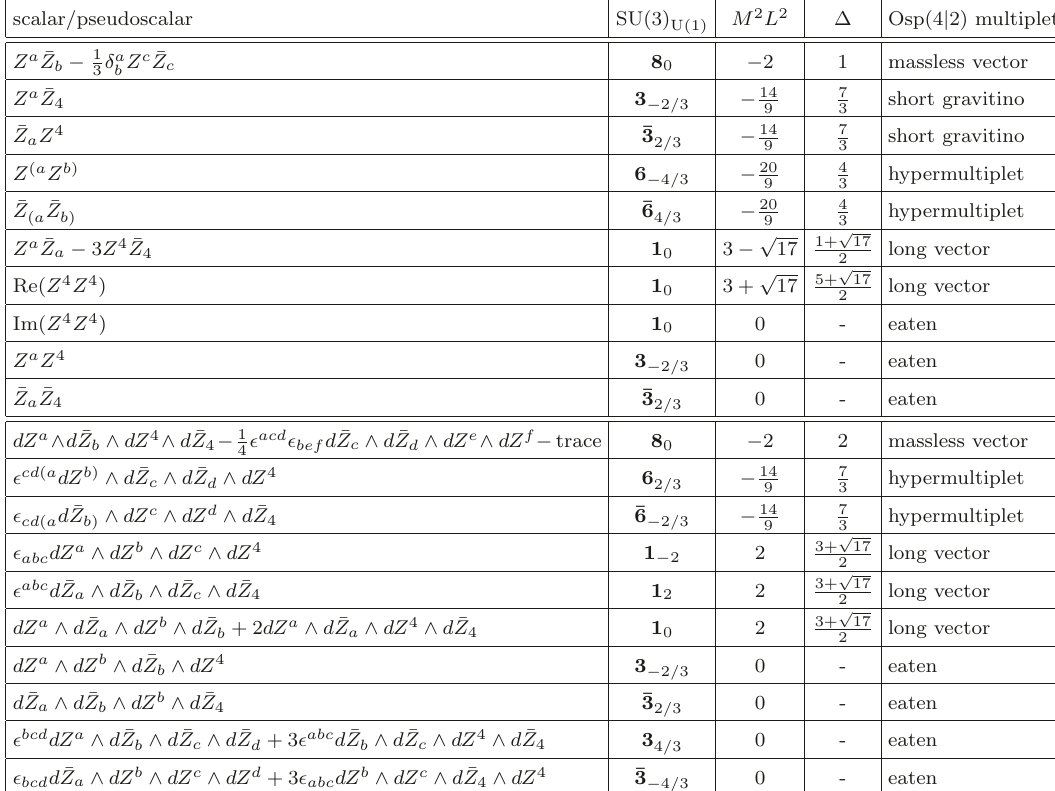
Table 4 . The spectrum of scalars and pseudoscalars on the of massive type IIA [7] at KK level n = 0. The OSp(4 according to table 3 is